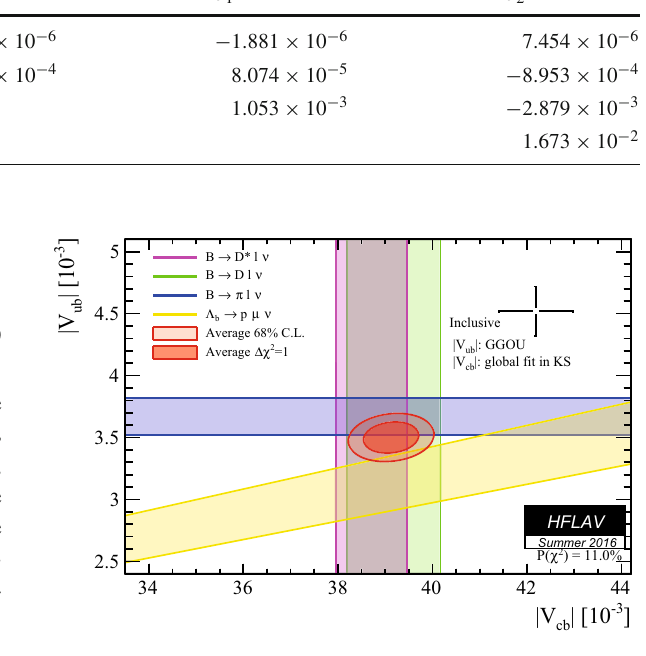
Fig. 60 | V ub | - | V cb | combined average including the LHCb measure- ment of | V ub | / | V cb | , the exclusive | V ub | measurement from B → π l ν , and | V cb | measurements from both B → D ∗ (cid:12)ν and B → D (cid:12)ν . The point with the error bars corresponds to the inclusive | V cb | from the kinetic scheme Sect. 5.2.2, and the inclusive | V ub | from GGOU calcu- lation Sect. 5.4.3